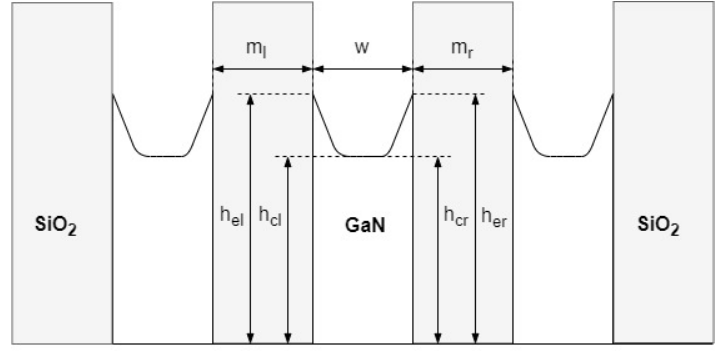
Figure 4. Parameters characterising the test structures.